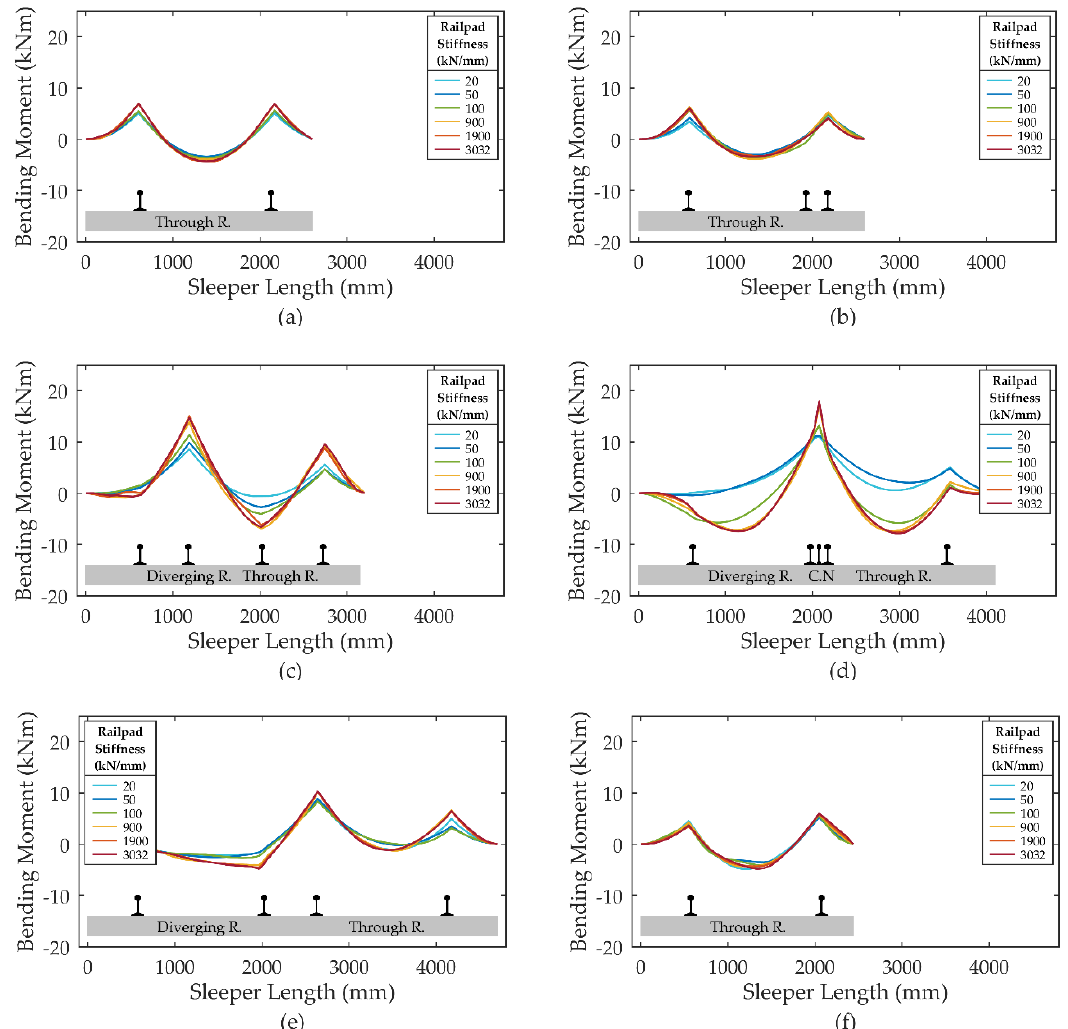
Figure 11. Bending moment distributions of specific sleepers with reference to different rail pad sti ff ness: ( a ) sleeper at the entrance; ( b ) sleeper under the switch blades; ( c ) sleeper at the closure panel; ( d ) sleeper under the crossing nose; ( e ) the longest sleeper; ( f ) the shortest sleeper.